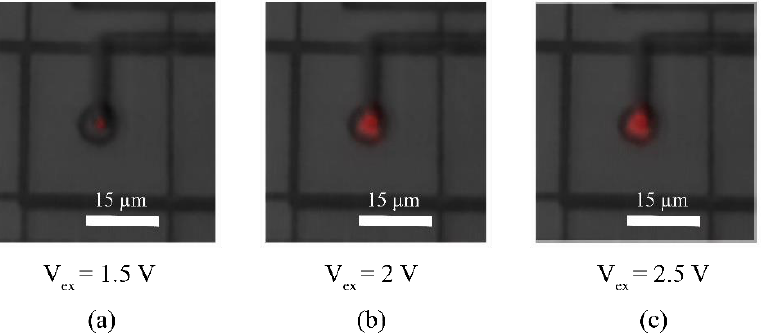
Figure 22. Light emission from “central SPAD” area at V ex = 1.5 V ( a ) , V ex = 2 V ( b ) and V ex = 2.5 V ( c ). The light emission is false-colored red.